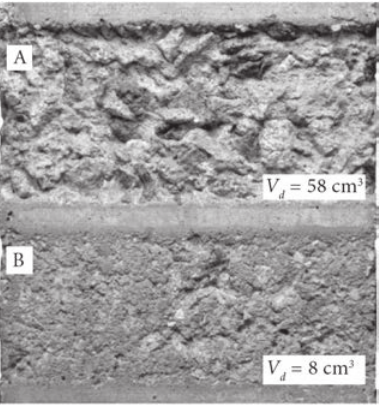
Fig. 5. Example of larger areas processed by flat pulsating jet (A) and flat continuous jet (B) in C45/55 concrete ( V d – disintegrated volume, water pressure: 30 MPa, equivalent nozzle diameter: 2.05 mm, standoff distance: 40 mm, traversing velocity: 0.2 m.min –1 )